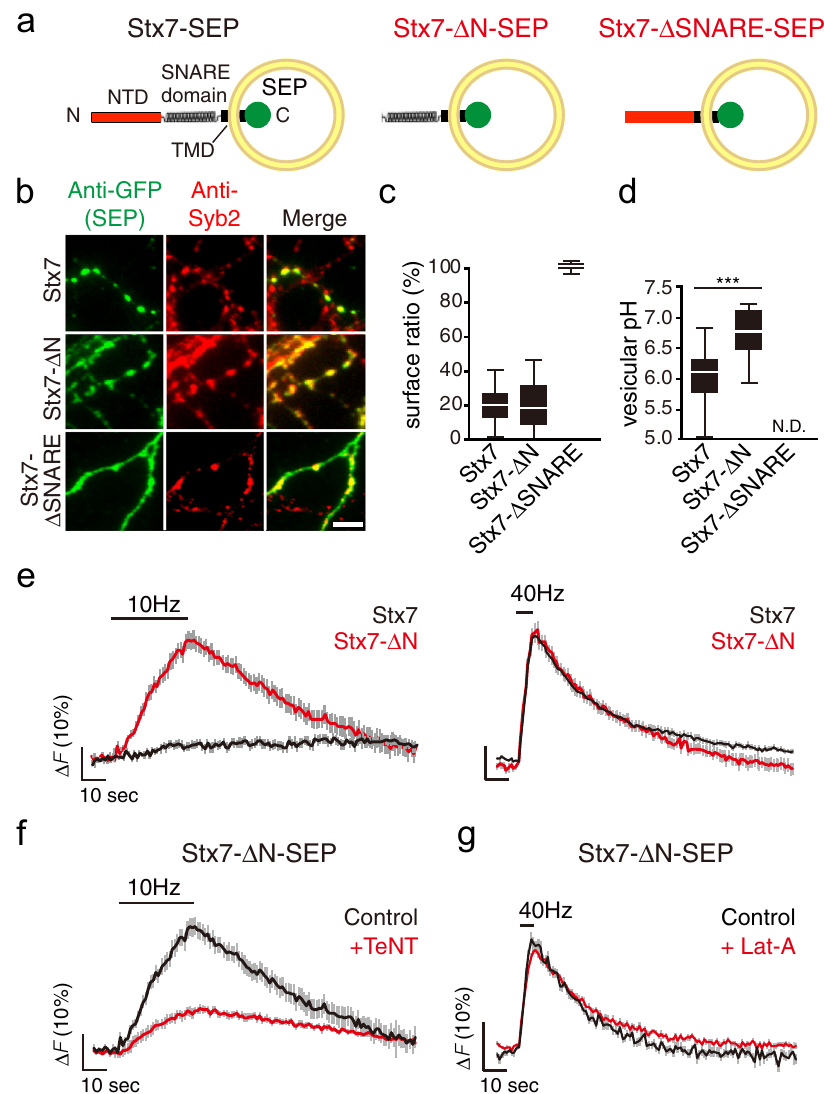
Fig. 6 The N-terminal domain of Stx7 is responsible for proper sorting of Stx7 to a subset of recycling SVs. a Schematic diagram of full length Stx7-SEP, Stx7-SEP lacking the N-terminal domain (Stx7- Δ N-SEP), and Stx7-SEP lacking SNARE motif (Stx7- Δ SNARE-SEP). b Distribution of Stx7-SEP, Stx7- Δ N-SEP, and Stx7- Δ -SNARE-SEP in transfected neurons. Box-whisker plots showing the surface fraction of Stx7-SEP and truncated mutants ( c ) and vesicular pHs of vesicles carrying respective SEPs ( d ). Note that vesicular pH of Stx7- Δ SNARE-SEP could not be calculated, since it was exclusively expressed at the cell surface (N.D. indicates ‘ not determined ’ ). e Responses of Stx7-SEP (black traces) and Stx7- Δ N-SEP (red traces) upon 10 Hz (left panels) and 40 Hz stimulation (right panels). f Responses of Stx7- Δ N-SEP upon 10-Hz stimulation in control (black) and after TeNT treatment (red). g Responses of Stx7- Δ N-SEP upon 40 Hz stimulation in control (black) and after Lat-A treatment